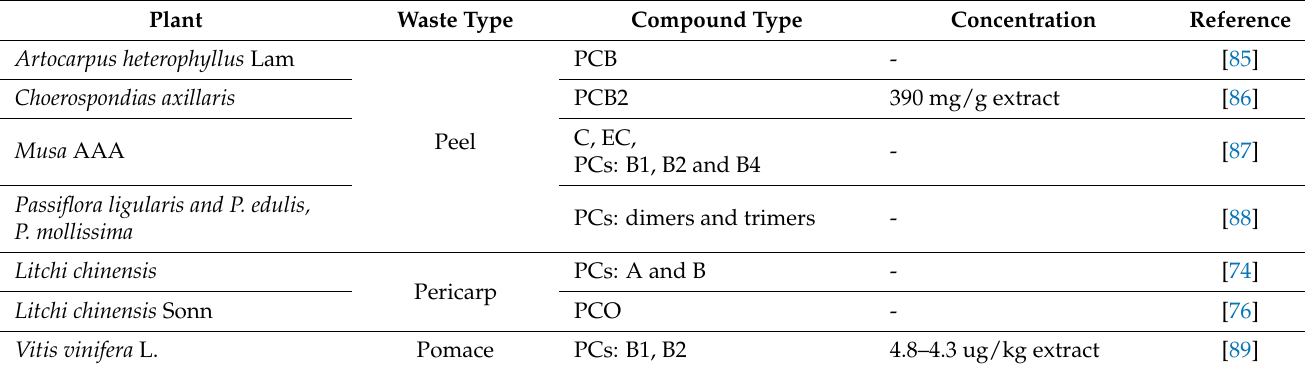
Table 1. Sources of procyanidins from agro-industrial